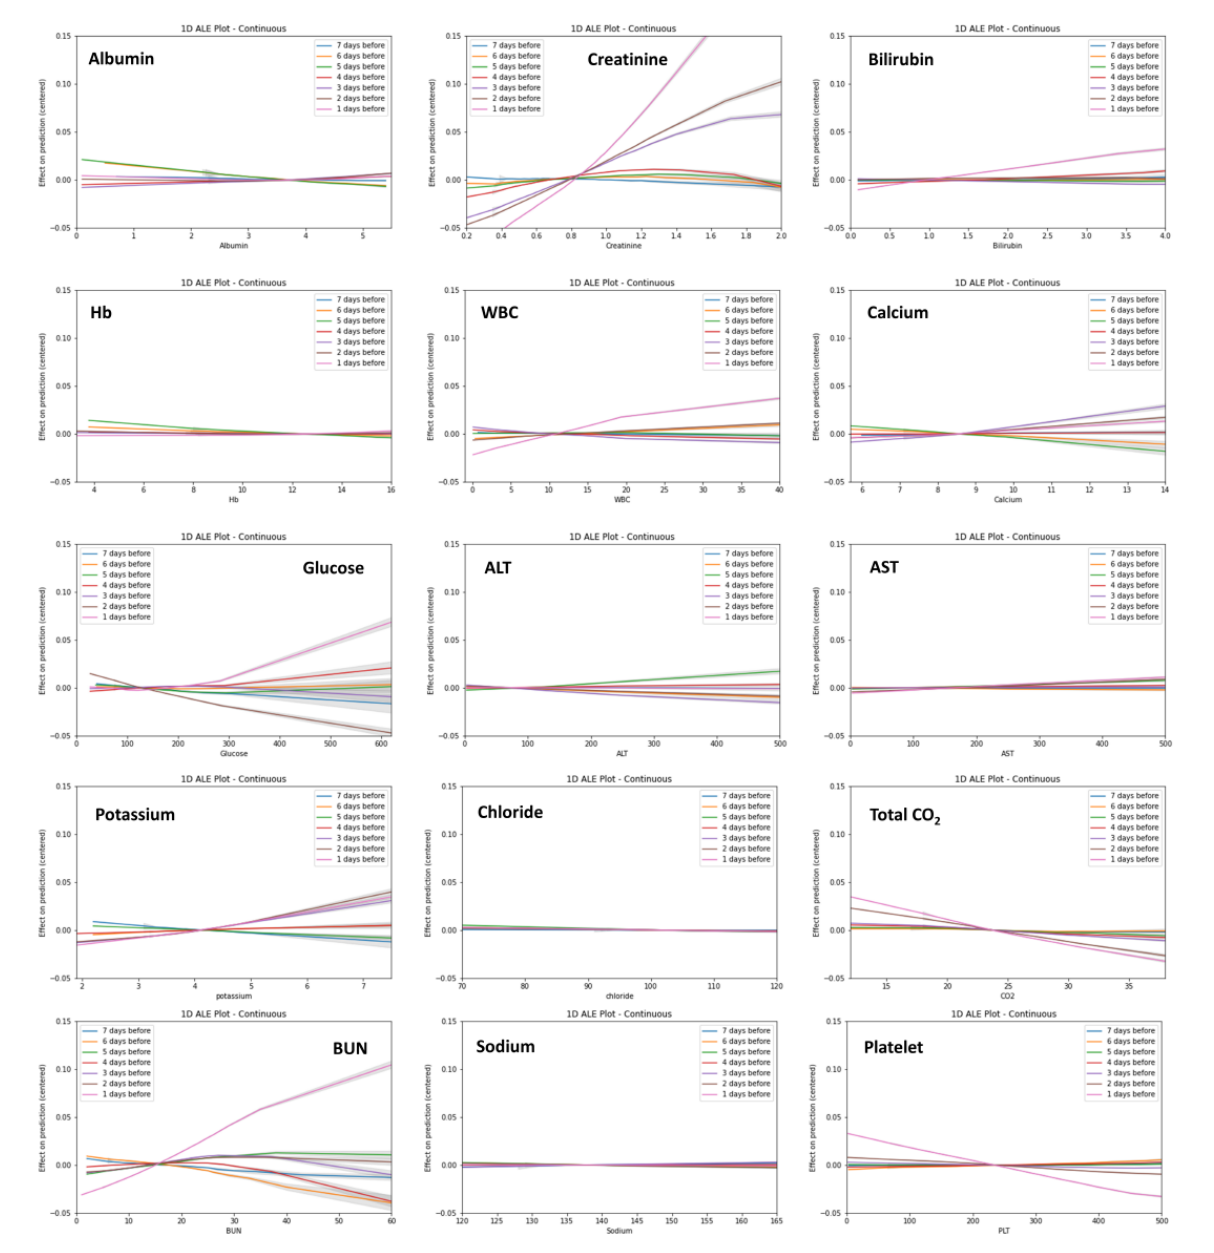
Figure 3. Accumulated local effects plots for the selected variables at the different time gaps from the prediction point. The same y-scale was used for all plots. AST: aspartate aminotransferase; ALT: alanine aminotransferase; BUN: blood urea nitrogen; Hb: hemoglobin; WBC: white blood cell